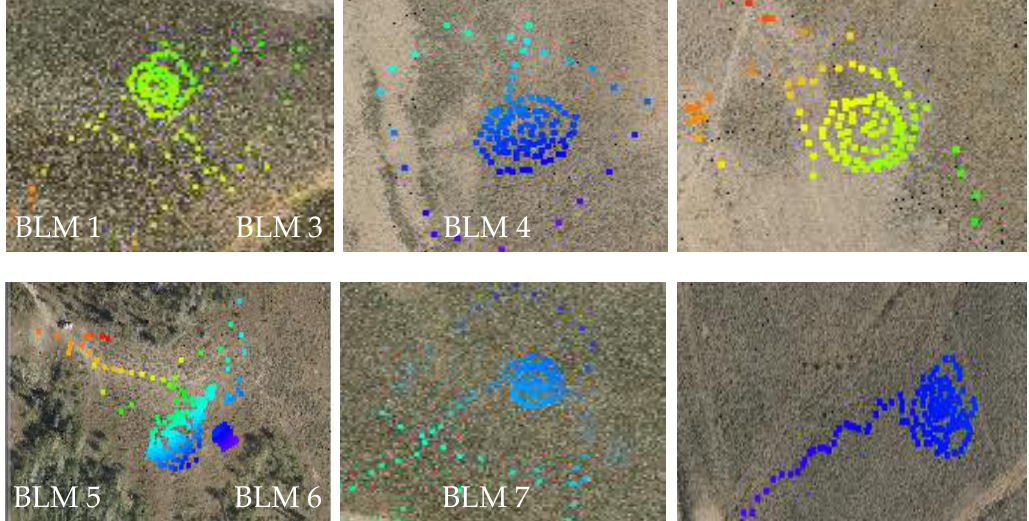
Figure 12. GNSS rover checkpoints for VVA analysis. Table 3. VVA analysis results in